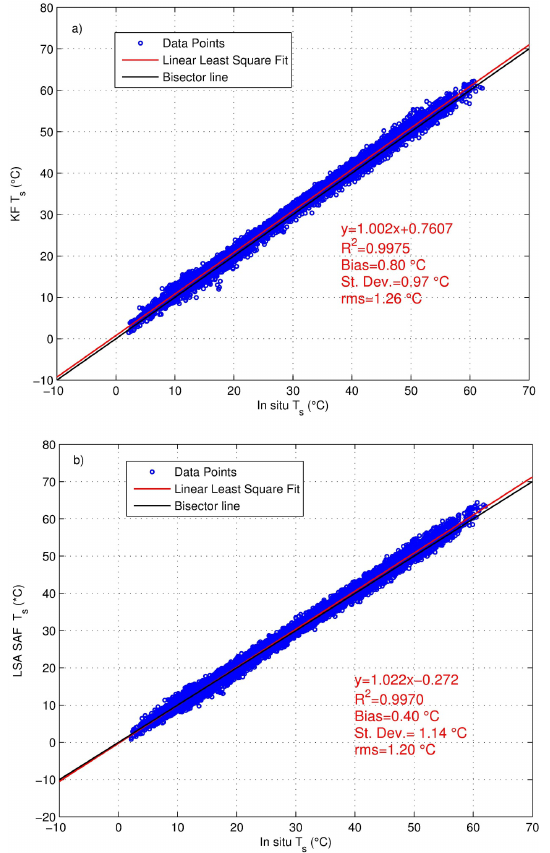
Figure 10. Scatterplot of SEVIRI surface temperature retrieval and in situ observations at Gobabeb for 2010. (a) KF (this study re- trieval) and (b) LSA SAF retrieval. Note: R 2 is the linear correlation coefficient.